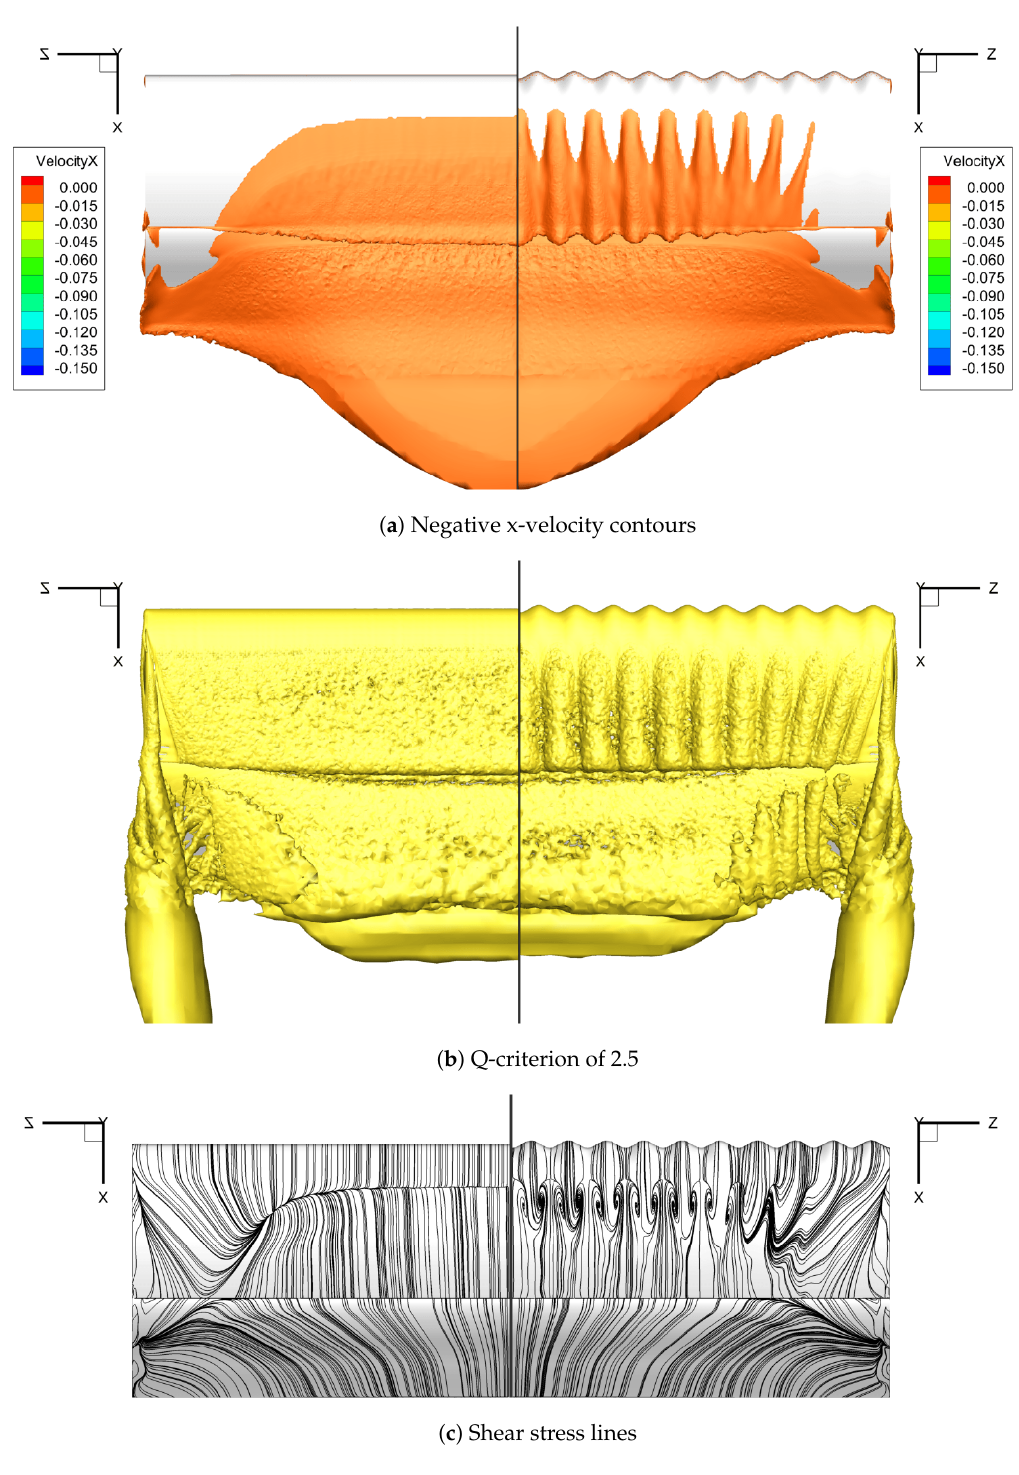
Figure 10. Comparison between the baseline (left) and the ME Tubercles (10 tubercles/2 A = 0.05 c ) (right) geometries. The geometries are seen from below and slightly from behind. The main element is at the top and the flap at the bottom. The flow is going from the top to the